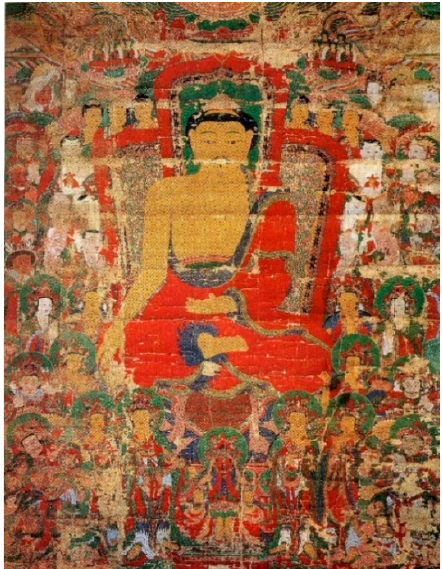
Figure 2. Sakyamuni Preaching , Joseon (1649), Color on hemp and silk, 652.7 × 430.5 cm, Bosalsa